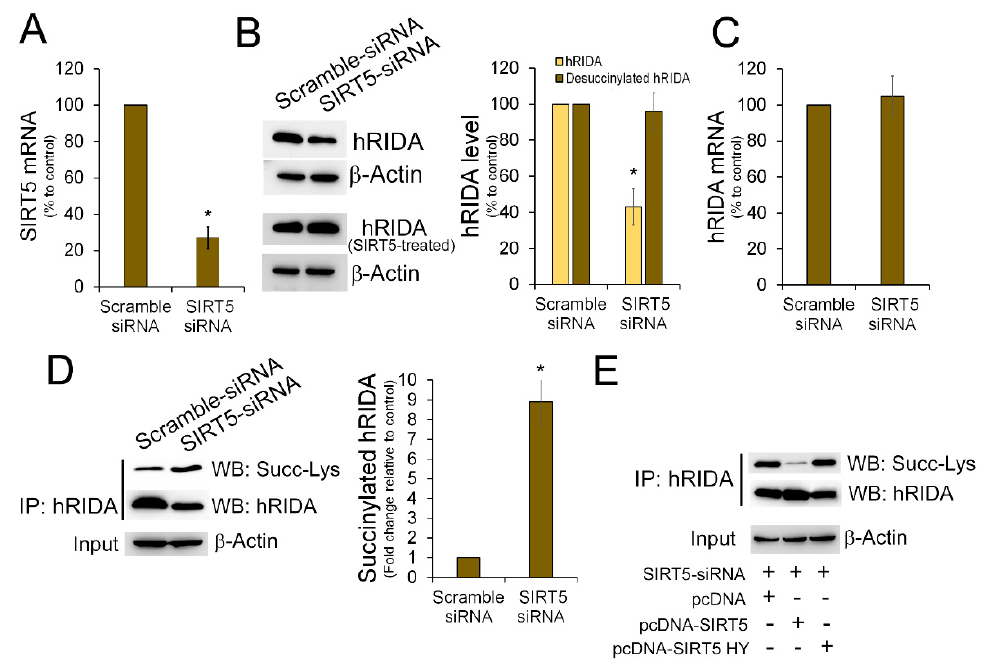
Figure 4. Down-regulation of SIRT5 enhanced hRIDA K-succinylation. ( A ) SIRT5 mRNA amount in scramble siRNA- (control) and in SIRT5 siRNA-transfected cells was determined by RT-qPCR and normalized with 18S rRNA. The abundance of SIRT5 mRNA in SIRT5 siRNA-transfected cells was reported in histogram as percentage of control. ( B ) The expression of hRIDA was analyzed by Western blotting in scramble siRNA-(control) and in SIRT5 siRNA-transfected cells. 20 µ g of untreated (upper panel) and SIRT5-treated (lower panel) protein extract from each sample was fractionated on 15% SDS-PAGE, transferred onto a nitrocellulose membrane and immunodecorated with the hRIDA polyclonal antibody. The content of hRIDA in SIRT5 siRNA-transfected cells was normalized with β -actin and reported in histogram as percentage with respect to control cells. ( C ) hRIDA mRNA amount in scramble siRNA-(control) and in SIRT5 siRNA-transfected cells was determined by RT-qPCR and normalized with 18S rRNA. The abundance of hRIDA mRNA in SIRT5 siRNA-transfected cells was reported in histogram as percentage relative to the control. ( D ) hRIDA was immunoprecipitated from scramble siRNA-(control) and in SIRT5 siRNA-transfected cells. Then, proteins were transferred onto a nitrocellulose membrane and immunodecorated with antibodies against succinyl-lysine (upper blot), and hRIDA (middle blot). The content of K-succinylated hRIDA was normalized with respect to β -actin in the input protein extracts (lower blot) and reported in histogram as fold change with respect to control cells. ( E ) HEK293 cells were transfected with SIRT5 siRNA. After 24 h, cells were transfected with the plasmid expressing SIRT5 (pcDNA-SIRT5), mutant SIRT5 H158Y, or the empty vector pcDNA for 24 h and then harvested. Endogenous hRIDA was immunoprecipitated from protein extract, and hRIDA and K-succinylated hRIDA were determined as described in ( D ). Values are means ± S.D. of three independent experiments. *, value significantly different from the control, p < 0.05.